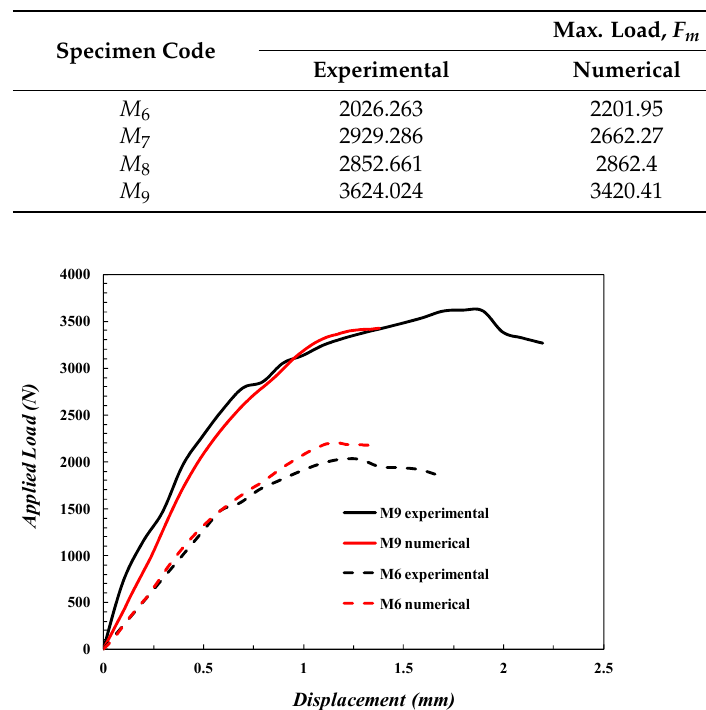
Figure 15. SPT Load–deflection curve for numerical and experimental results for the SPT speci ‐ men.